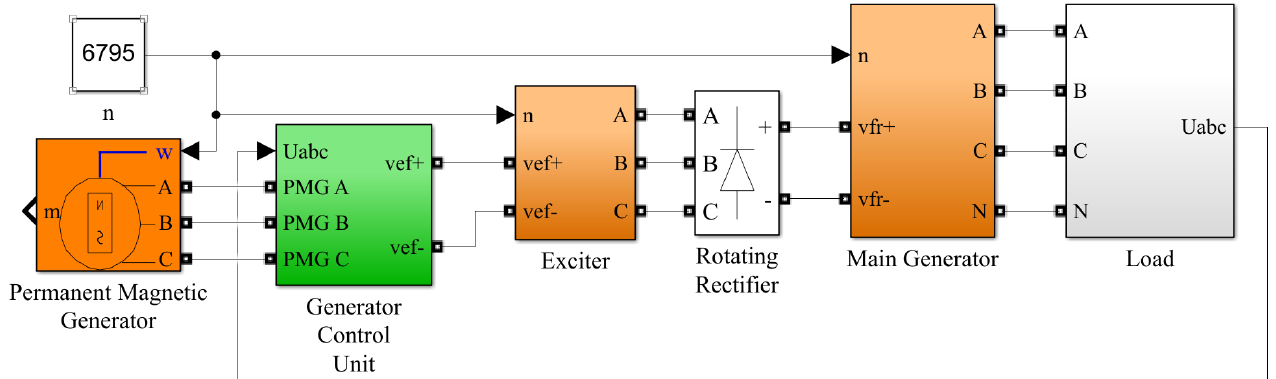
Figure 10. Simulink model of the BSG system.